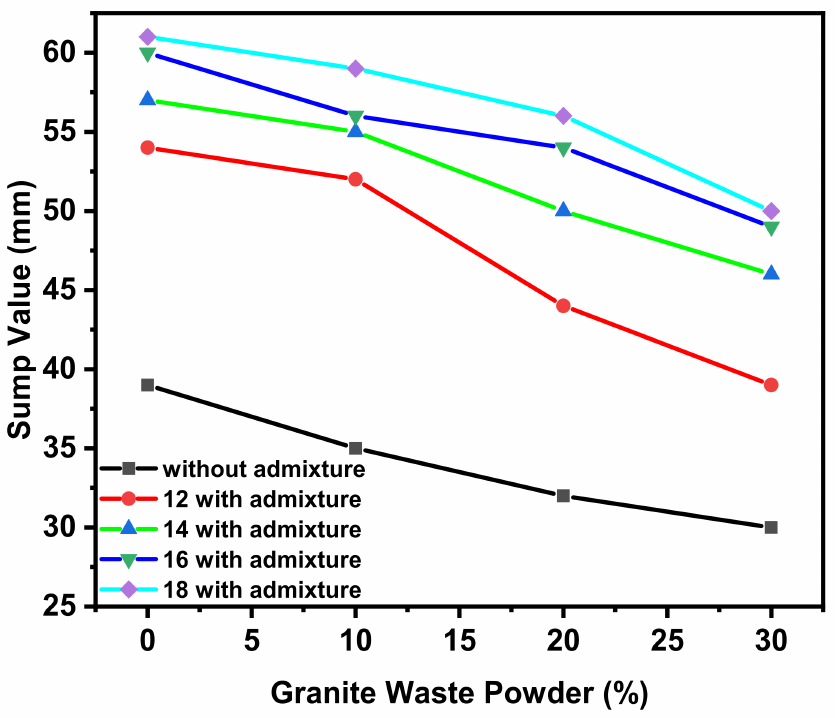
Figure 1. For other percent of GWP and molarity, the slump value results are shown. The ratio of Na 2 SiO 3 /NaOH plays a vital role in the enhancement of slump. GWP is combined with the NaOH agent. The result is a cohesive and sticky GPC. The lower the water to binder ratio, the stronger the GPC [36]. A lower Si/Al ratio in the mix causes a slower reaction, and the slump is reduced. The slump value in GPC decreased when the ratio of Na 2 SiO 3 /NaOH increased, owing to the high viscosity of sodium silicate, which restricted the flow of mixes [37–39]. Because C-A-S-H was created, which decreases the slump value, higher CaO concentration in GGBS resulted in faster development of setting time. The shape of particles has more significant influences on the effect of workability of GPC